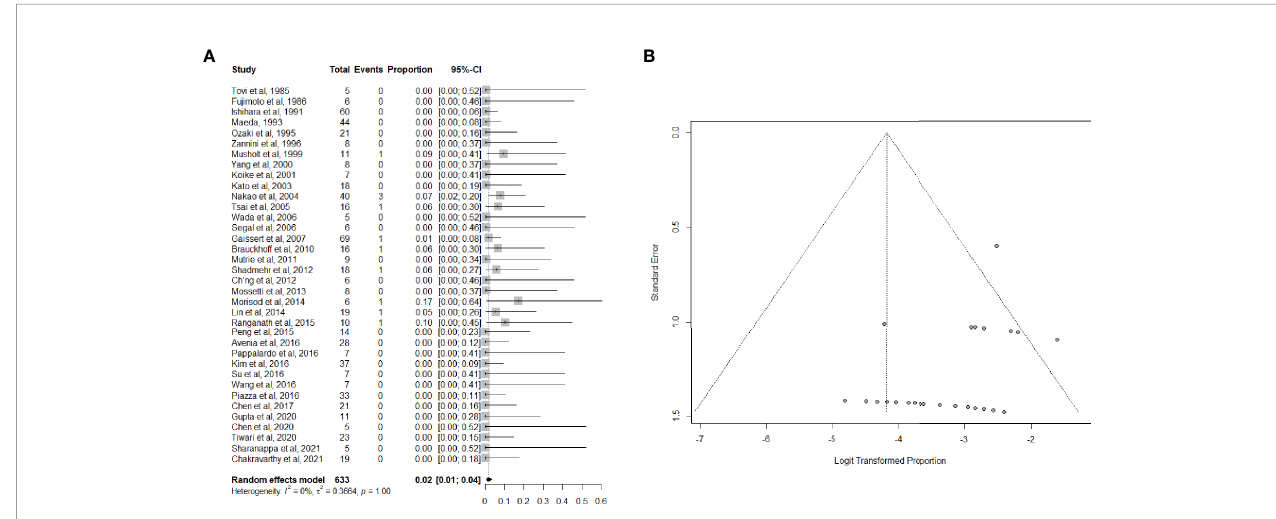
FIGURE 2 | (A) Forest plot showing the pooled analysis of postoperative mortality and (B) relative funnel